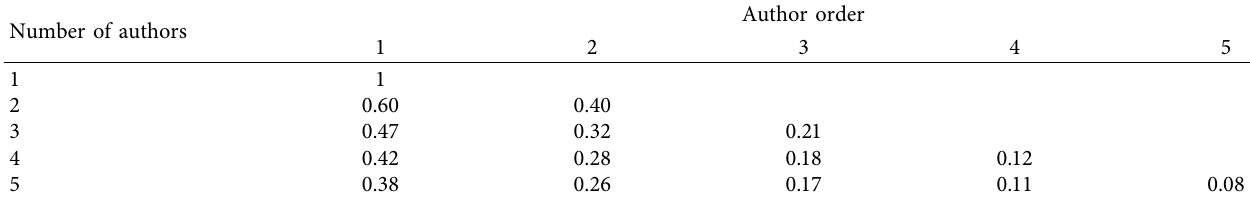
Table 1: Scores for papers with multiauthors (first author � corresponding author).